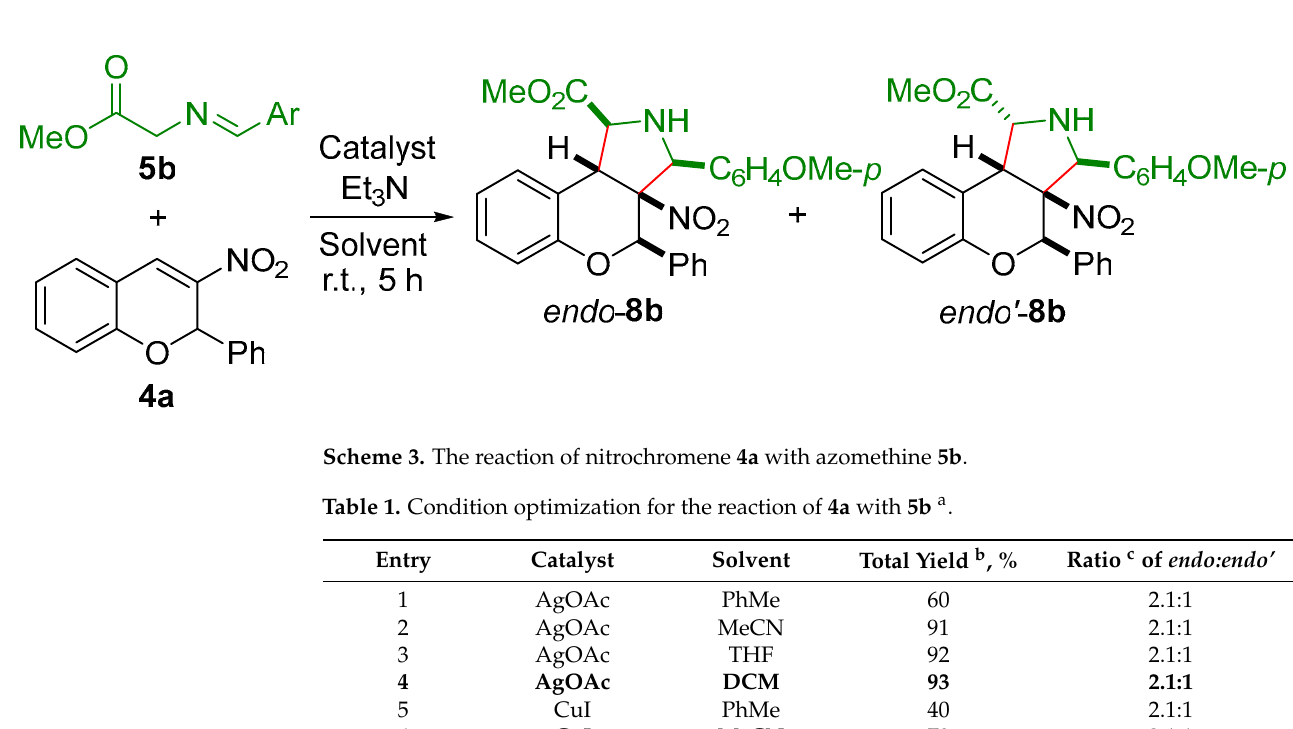
a Conditions: a mixture of 4a (63 mg, 0.25 mmol) and 5b (58 mg, 0.28 mmol) was stirred at room temperature in 1 mL of the corresponding solvent for 5 h in the presence of Et 3 N (2.9 mg, 0.025 mmol) and the corresponding catalyst (0.025 mmol). b Isolated yield. c Determined by 1 H NMR spectroscopy of the reaction mixtures.